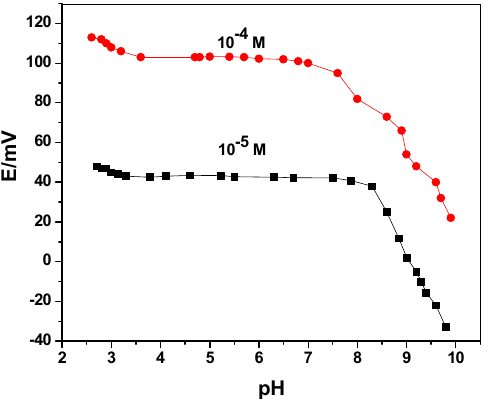
Figure 3. The effect of pH on the potentiometric response of C/SWCNTs/MIP-ODV sensor.